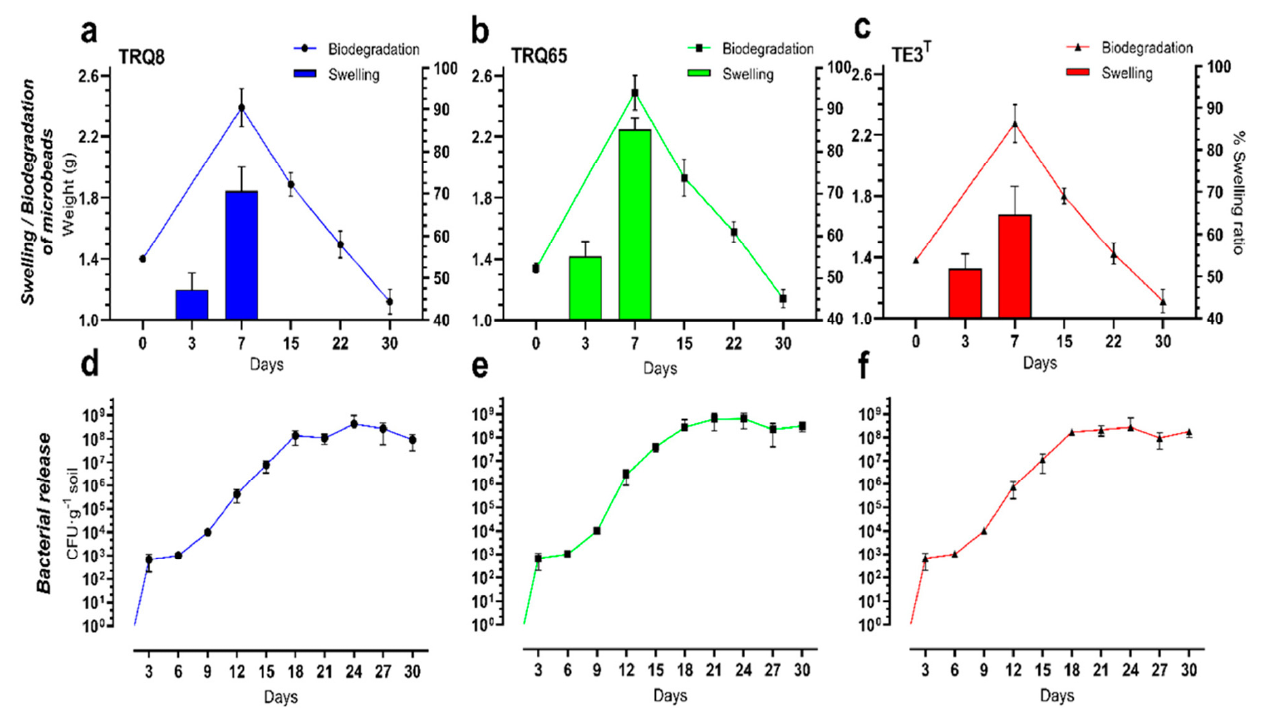
Figure 4. Biodegradation and swelling ratio of microbeads ( a – c ) and Bacillus strains establishment ( d – f ) in soil. Bars indicate the standard